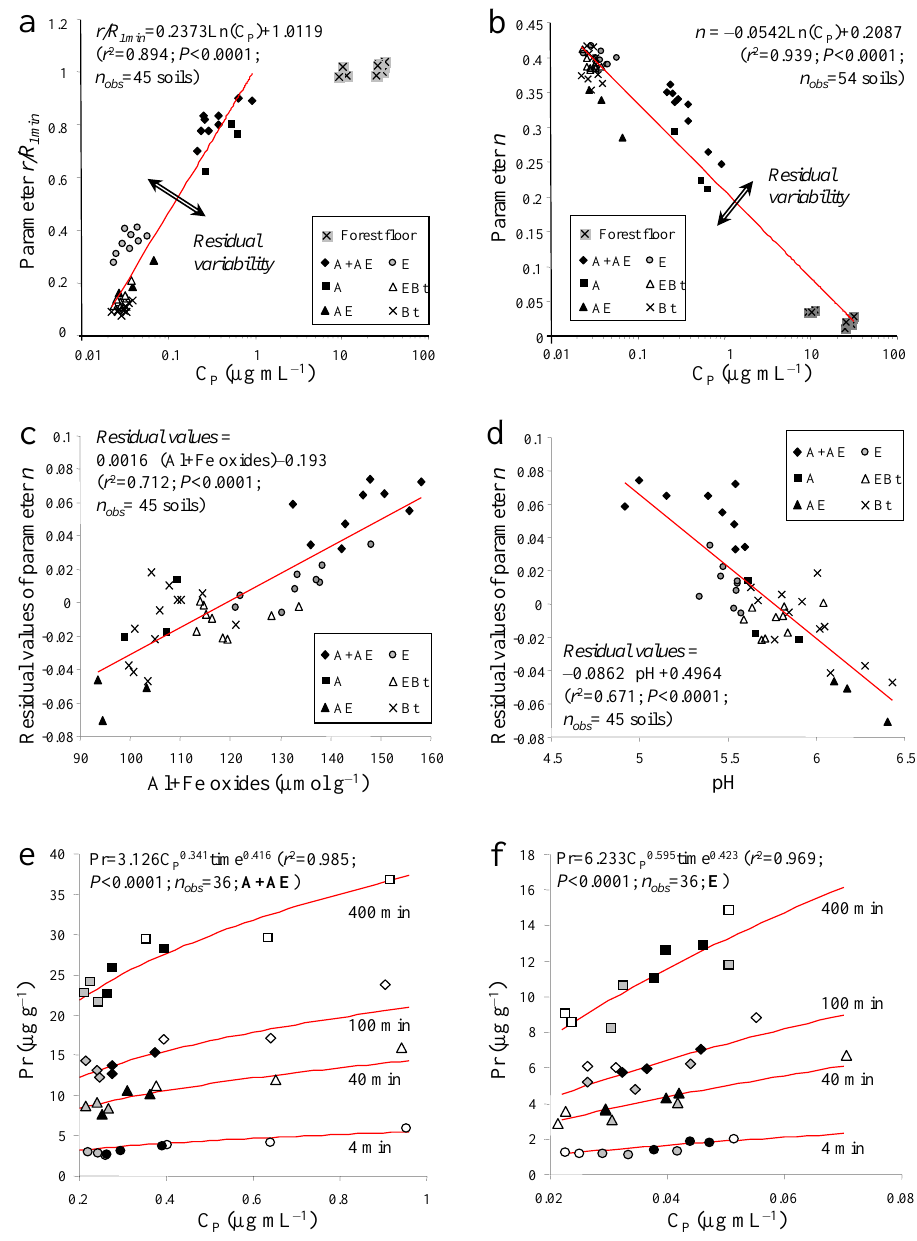
Fig. 2. Effects of soil properties on isotopic dilution parameters and diffusive phosphate ions. Isotopic dilution parameters ( r/R 1 min in a ; n in b ) as a function of the concentration of phosphate ions in soil solution (C P ) , considering all plots (3 zones per plot) and soil horizons. Relationships between the residual variability of parameter n (measures – estimated values with C P ; see arrow in b ) and Al + Fe oxides extracted with ammonium oxalate ( c ) and soil pH ( d ). Diffusive phosphate ions (Pr) as a function of time and C P in a given mineral soil horizon of the three adjacent plots (A + AE horizon in e ; E horizon in f ; open symbols, plot 1; grey symbols, plot 2; black symbols, plot 3). Solid lines , non-linear or linear adjustments (adjustments of the Freundlich kinetics Eq. (7) in e and f ). Stepwise procedure: residual values on parameter n = 0 . 108 + 0 . 000937×(Al + Fe oxides) – 0.039 × pH + 0.000416 × total C ( r 2 = 0 . 816; P< 0 . 0001; n obs = 45 mineral